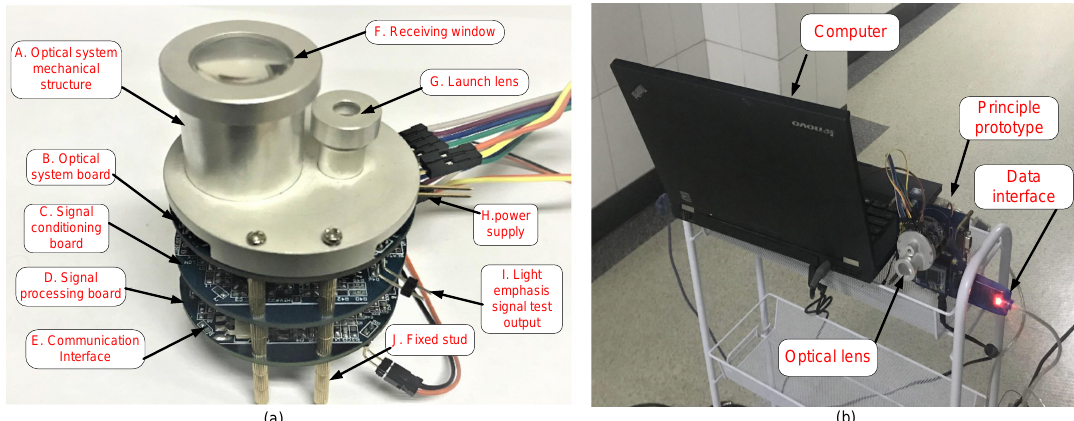
Figure 9. ( a ) shows the composition of FMCW laser fuze prototype; ( b ) the collected IF signal data are transmitted to the computer for